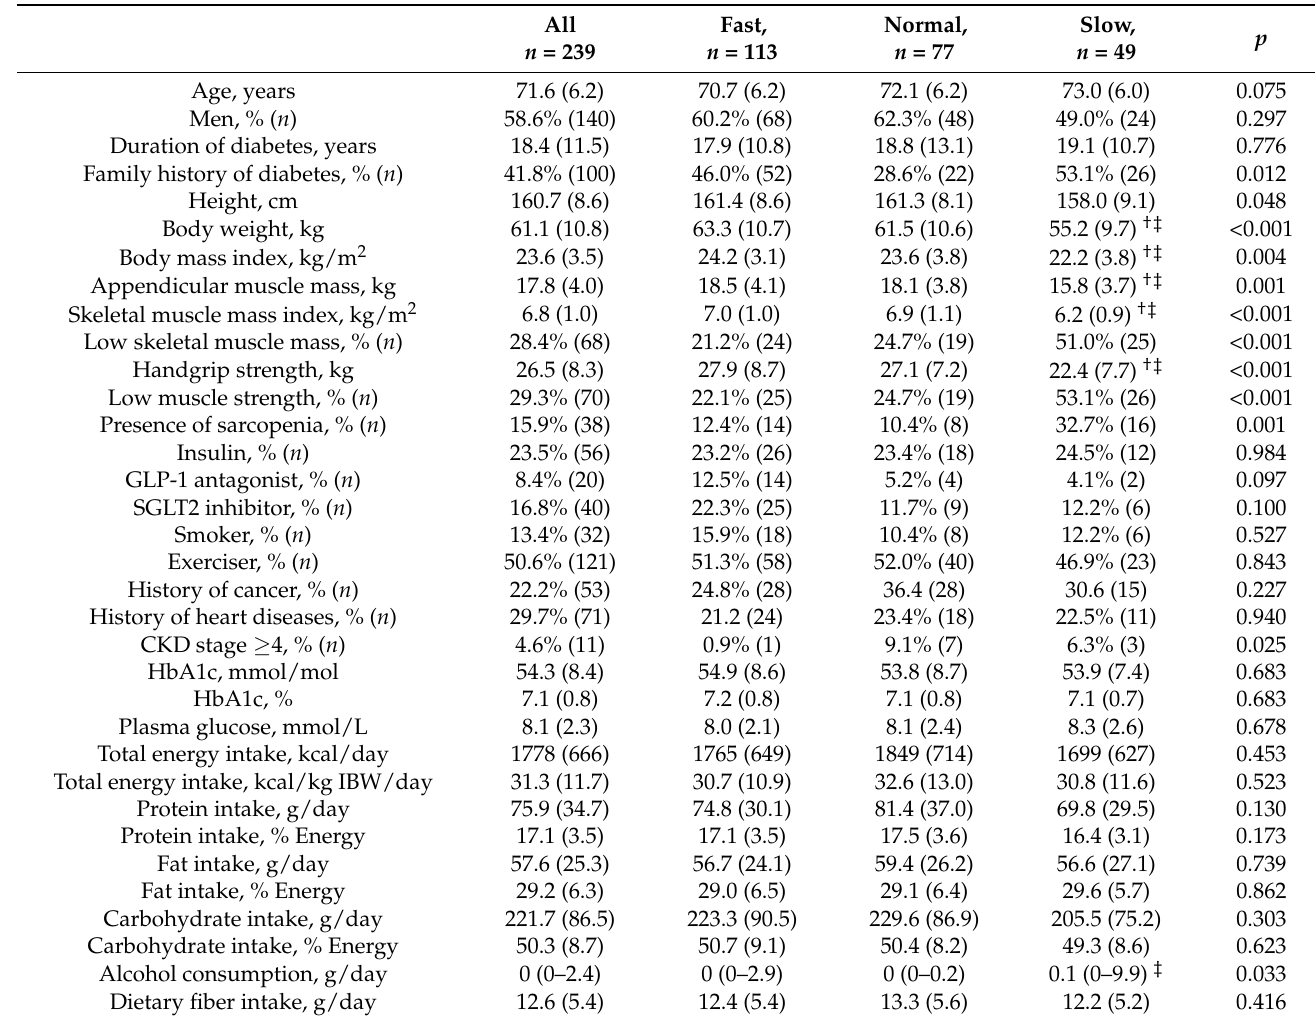
Table 1. Clinical characteristics of study